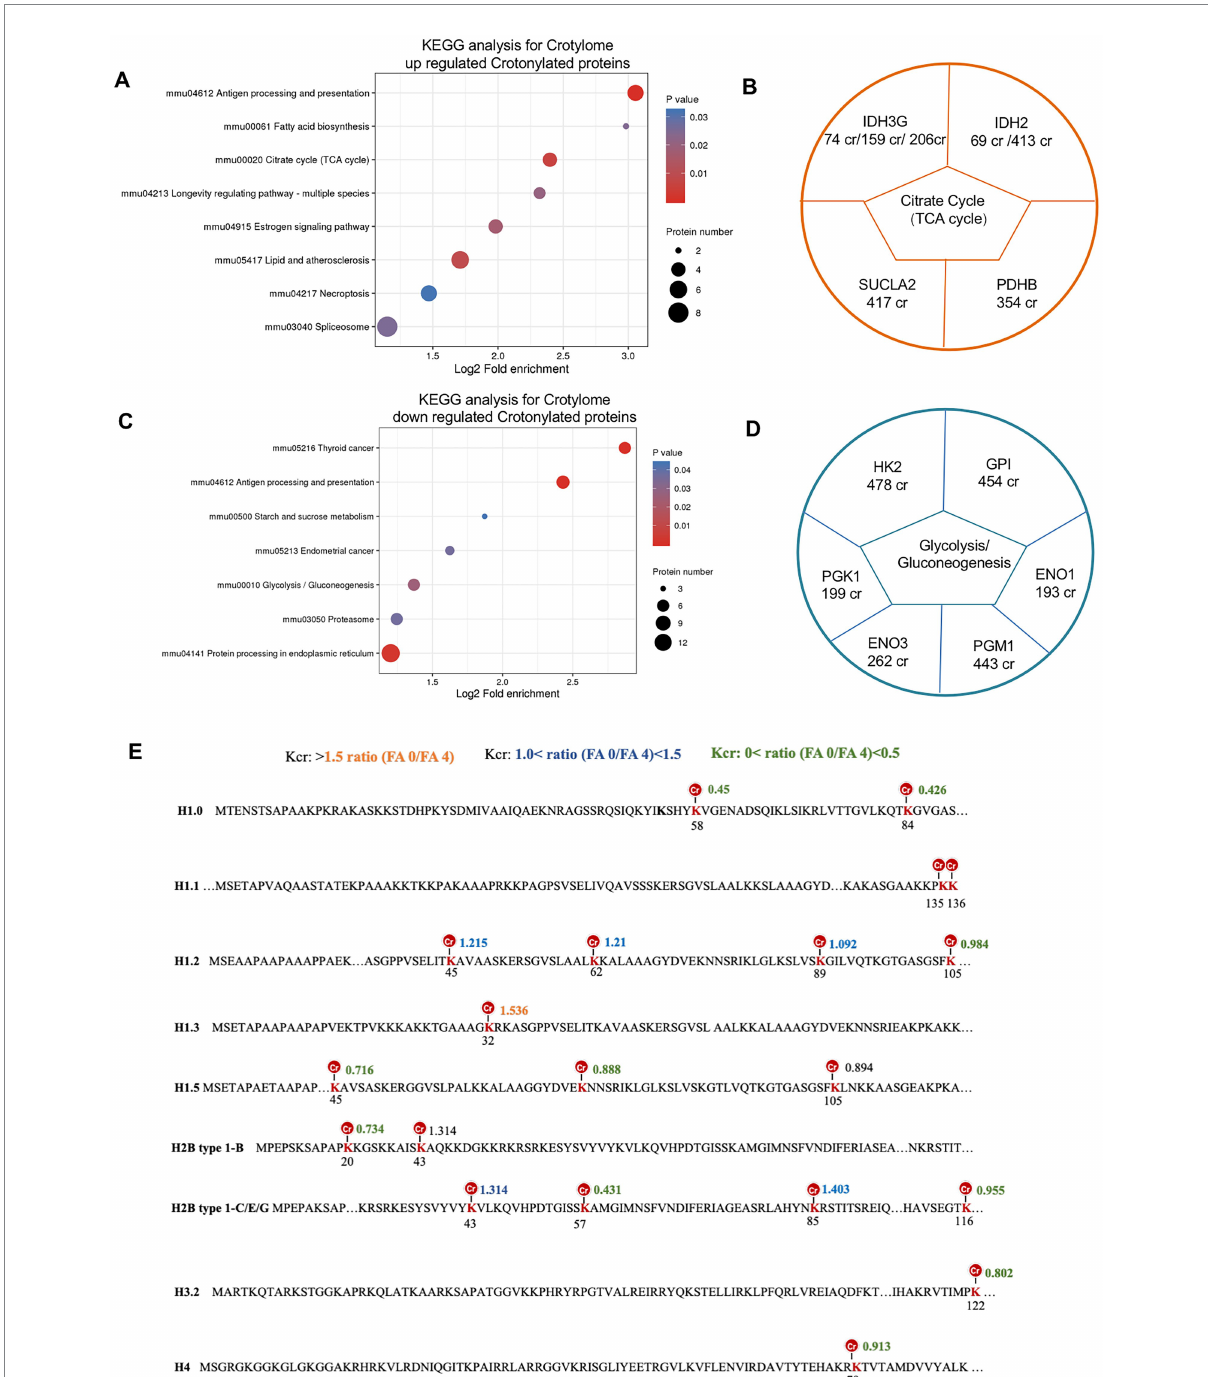
FIGURE 8 Crotonylated lysine in extensive protein network in folate-free mESCs. (A,C) Enrichment analysis of overrepresented KEGG pathways within (A) up-regulated or (C) down-regulated crotylated proteins in folate-free mESCs (FDR < 0.05). (B, D) Selected crotylated sites on significantly enriched metabolism pathways and quantification of exemplary crotylated sites that were (B) upregulated or (D) downregulated in folate-free mESCs. (E) Histone Kcr sites identified and quantitative crotonylome analysis in normal folate versus folate-free mESCs. Histone lysine sites with different changes in the Kcr level are